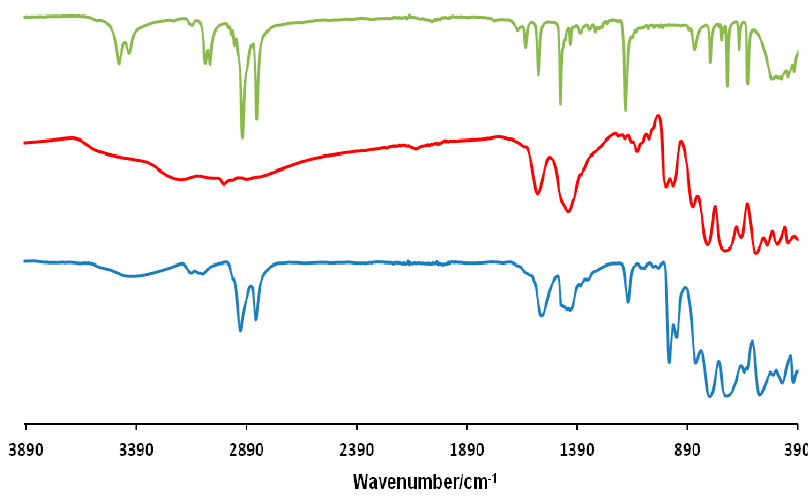
Figure 2. FT-IR spectra of (mimC 18 )Br ( green ), NH 4 –Mo 132 ( red ) and (mimC 18 ) 37 –Mo 132 ( blue